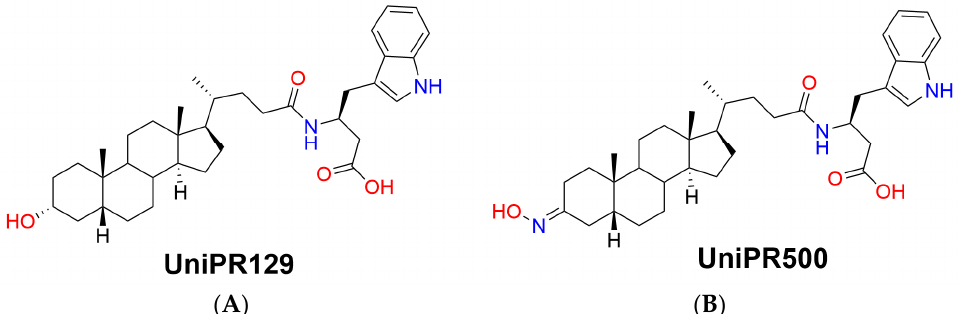
Figure 1. Chemical structures of ( A ) parent Eph–ephrin PPI inhibitor UniPR129 and ( B ) its 3- hydroxyimino derivative UniPR500.